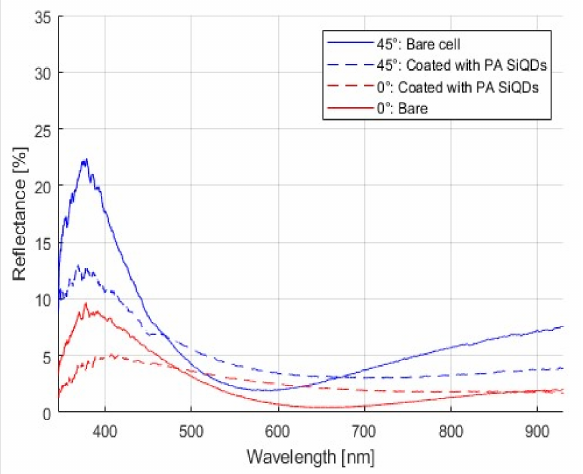
Figure 3. Diffuse and specular reflectance measured at 45 ◦ and 0 ◦ , respectively, for the bare and PA Si-QD coated pc-Si solar cell sample Q2.